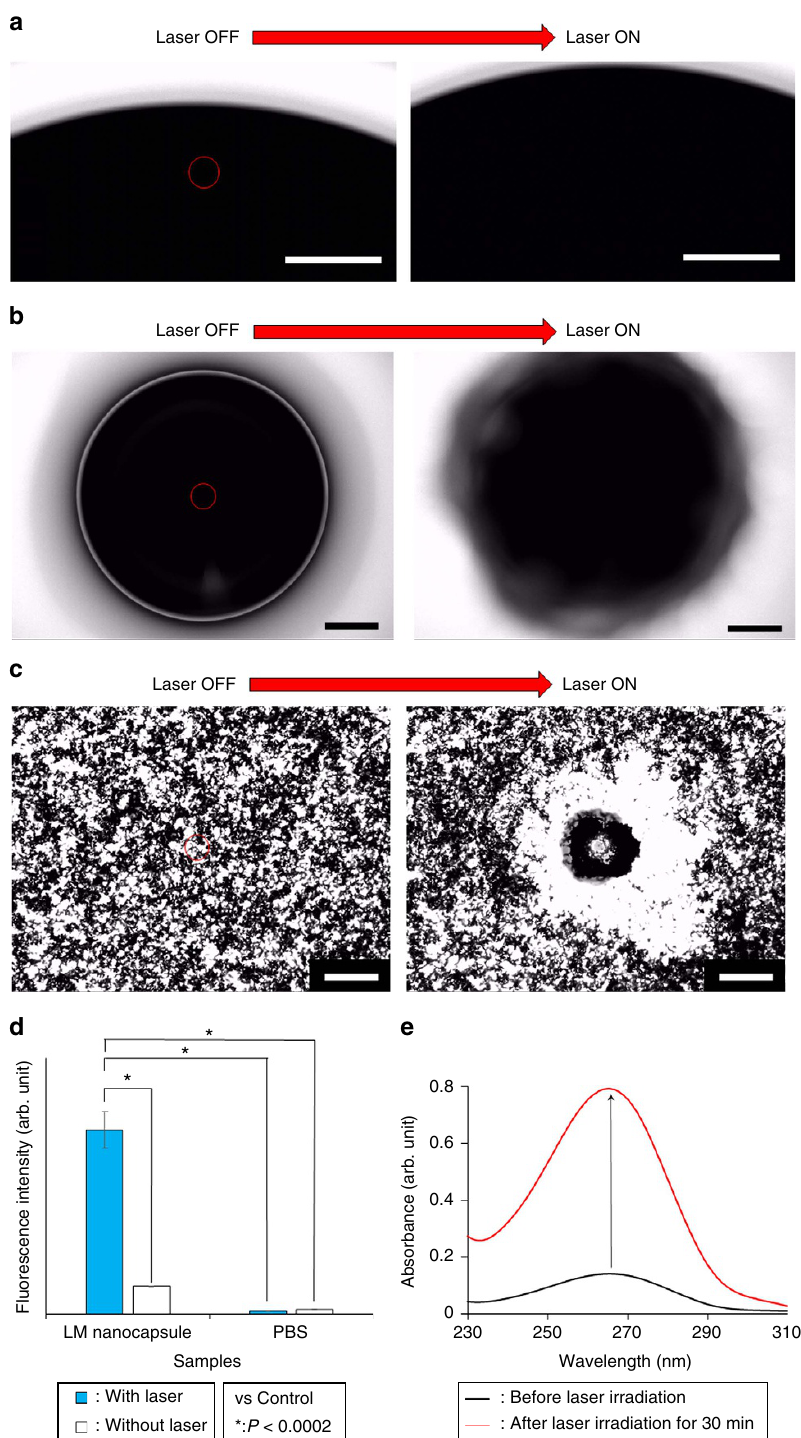
Figure 4 | Optical and drug control releasing properties of laser-induced LM. Thermal expansion of laser-driven LM droplet in a the air (Scale bars, 150 m m) and ( b ) 0.1 M NaOH solution (Scale bars, 100 m m). ( c ) Morphological changes of LM aqueous suspension before and after laser irradiation. The red circles show laser irradiation position and area. Wavelength of laser ¼ 808nm, laser power ¼ 564mW ( B 287 m W m m (cid:2) 2 ). Samples were prepared without DSPE-PEG 2000 -Amine and DC(8,9)PC. Scale bars, 100 m m. ( d ) ROS generation by photo-induced DSPE-PEG 2000 -Amine-DC(8,9)PC-LM after 30min laser irradiation (785nm, 1W, B 80mWmm (cid:2) 2 ). Error bars represent s.d.’s of three separate measurements. * P o 0.0002. ( e ) Controlled release of carmofur from laser-stimulated LM